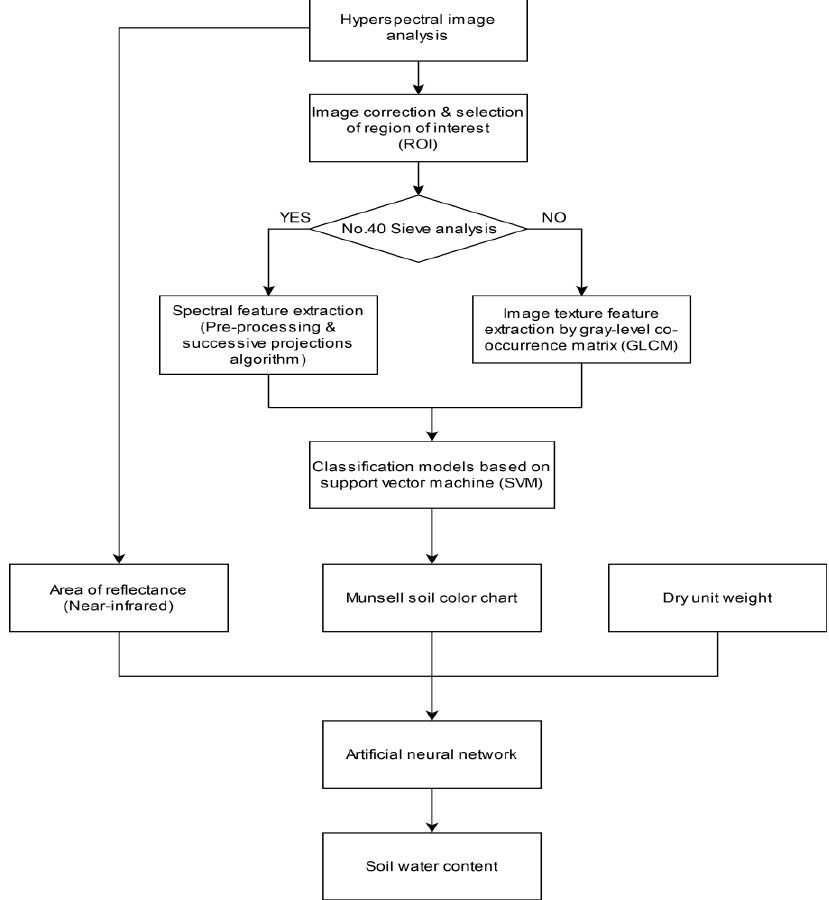
Figure 5. Overall flowchart showing the sequence of steps involved in the procedure of soil classification and the artificial neural network (ANN) for the prediction of soil water content.